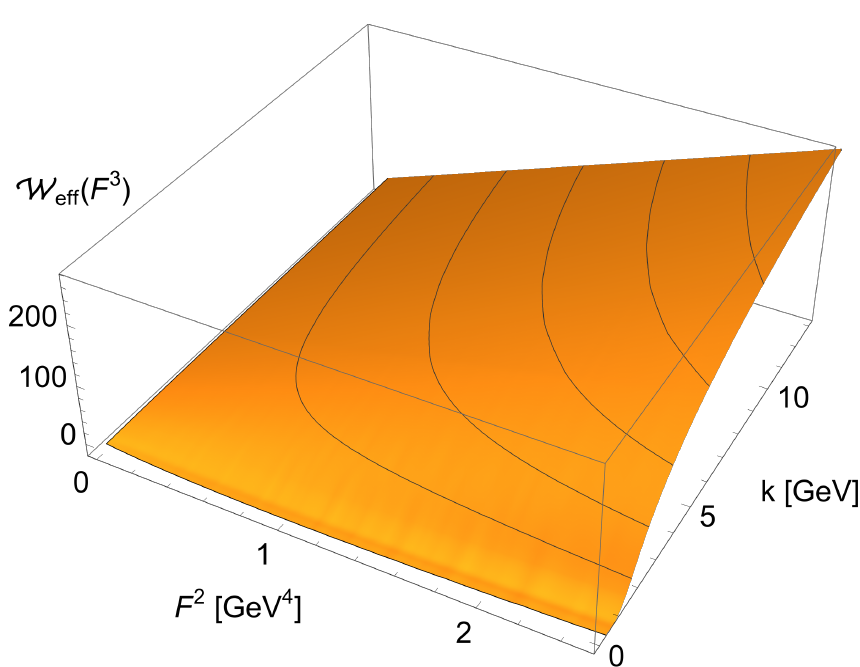
( F a ) , defined in eq. (64), for F a = F δ a 3 as a function Figure 7: Effective Potential W k of F 2 obtained from integrating the flow with the regulator eq. (93). In comparison to Figure 5b the regulator is much smoother, which translates to the smoothness in (cid:166) k (cid:166) 1 GeV. k on